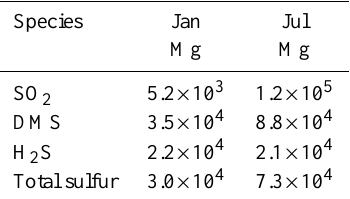
Fig. 2. Percent distribution of natural gaseous sulfur (SO 2 +DMS+H 2 S) emissions by source. Table 1. Monthly emissions totals for naturally occurring sulfur gases within the atmospheric modeling